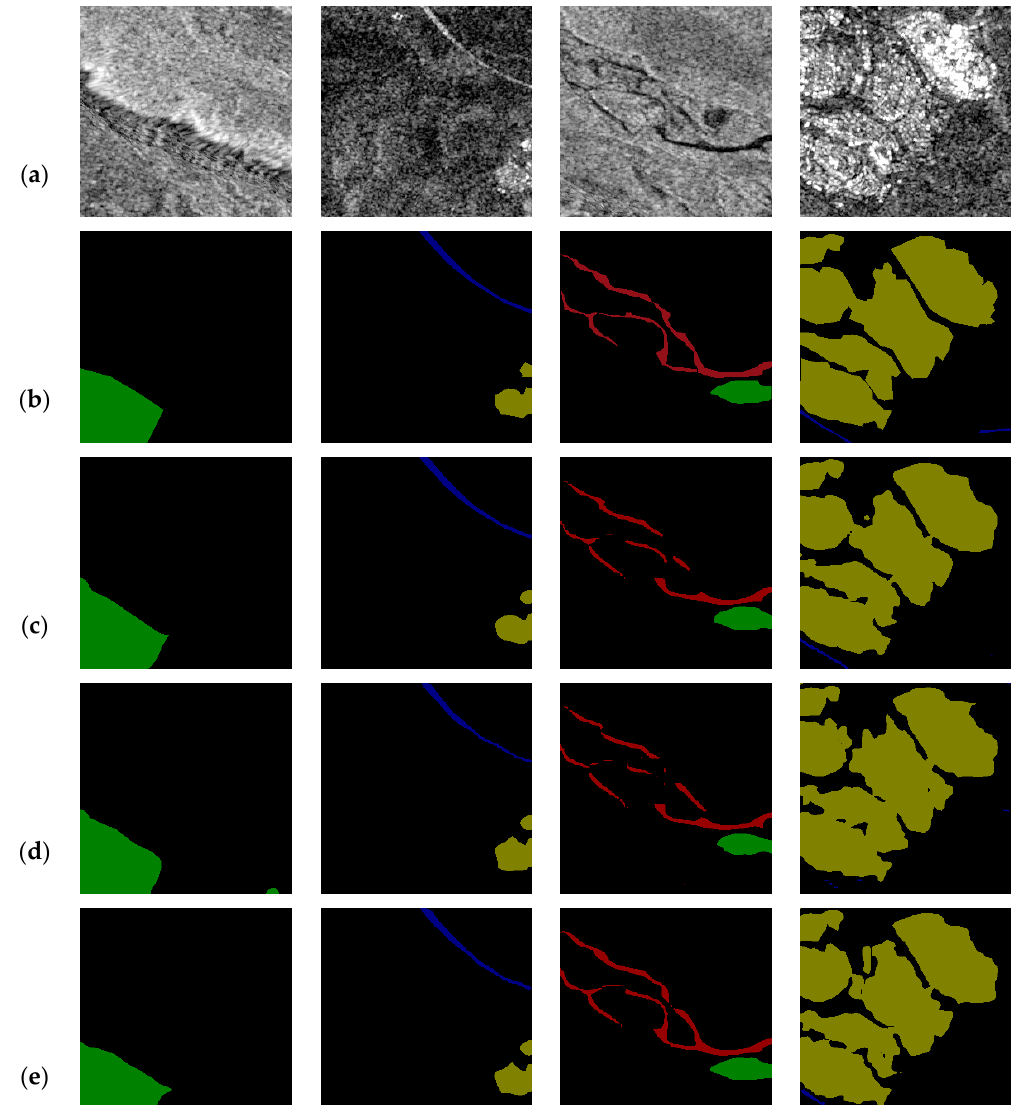
Figure 6. The results of the three different networks: ( a ) SAR imagery; ( b ) ground truth; ( c ) Deeplabv3–drn output; ( d ) Deeplabv3–ResNet output; ( e ) Deeplabv3–Mobilenetv2 output.